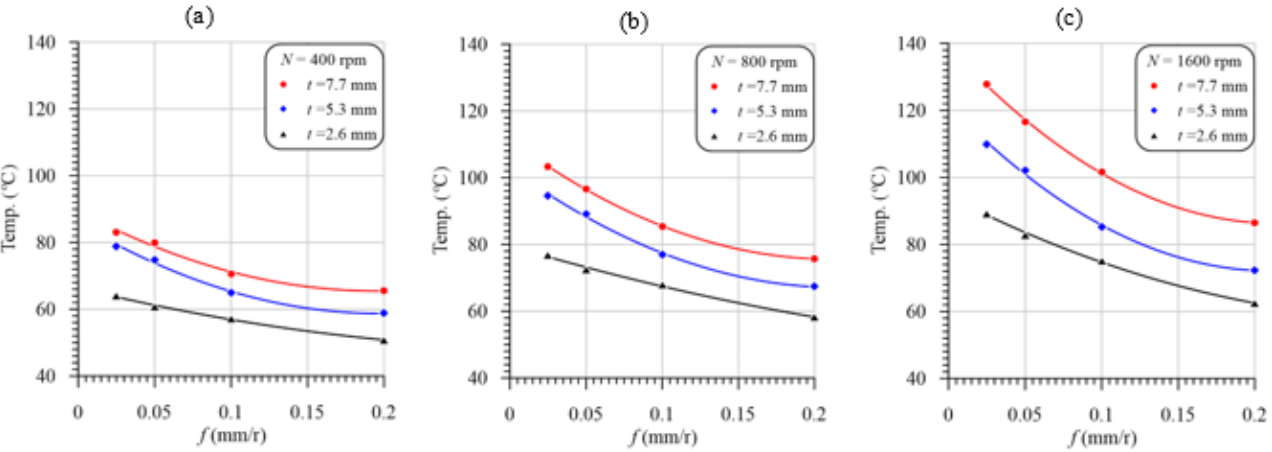
Figure 9. Temperature vs. feed with different laminate thicknesses and speeds of ( a ) 400 rpm, ( b ) 800 rpm, and ( c ) 1600 rpm.